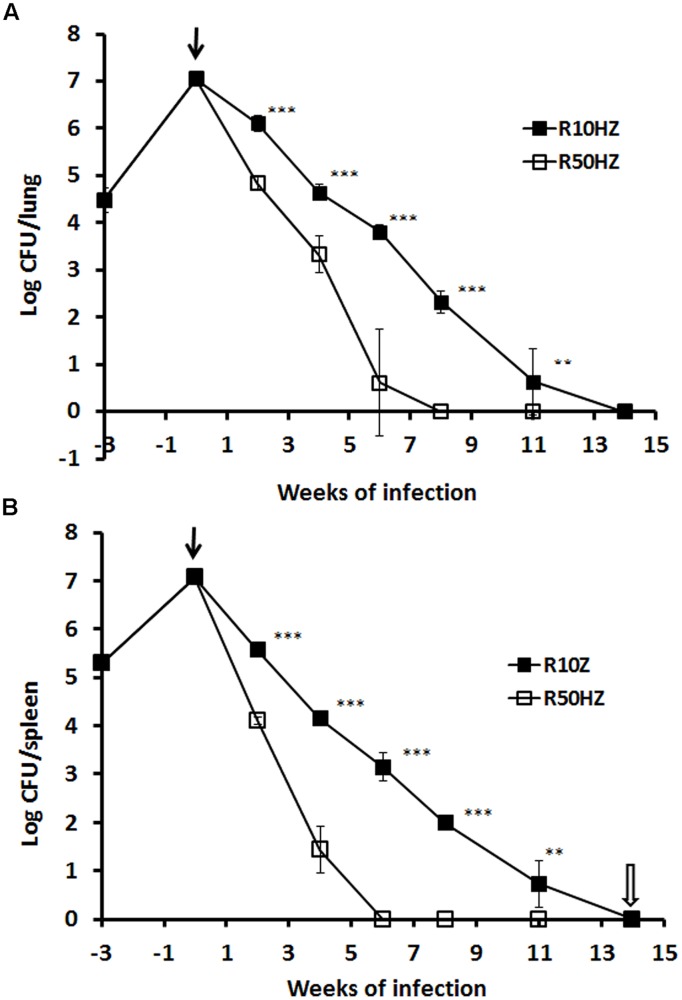
Viability of M. tuberculosis H37Rv in the mouse Cornell model of dormancy. The results of a single experiment are shown with viability expressed as log CFU counts per lung (A) and spleen (B). Mice were infected intravenously at week –3 and the infection was allowed to progress for 3 weeks prior to treatment with isoniazid and pyrazinamide with rifampicin added at 10 or 50 mg/kg indicated as a solid arrow for 14 weeks (time weeks 0–14). At week 2, 4, 6, 8, 11, and 14 of post-treatment, CFU counts in the organs from each group were estimated. Steroid treatment was started immediately after the termination of 14 weeks of antibiotic treatment as indicated with an empty arrow. The experiment has been performed twice with reproducible results. Statistical analysis demonstrated that the decline of CFU counts in lungs and spleens was significant between low and high-dose rifampicin regiments, ∗∗∗P < 0.0001 or ∗∗P < 0.02 (Student’s t-test).